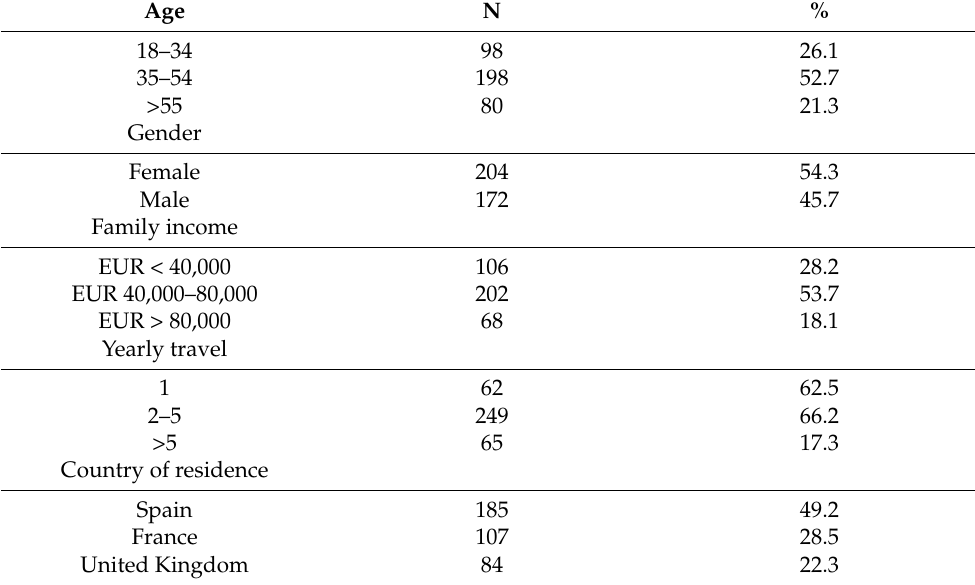
Table 1. Demographic profile (N =